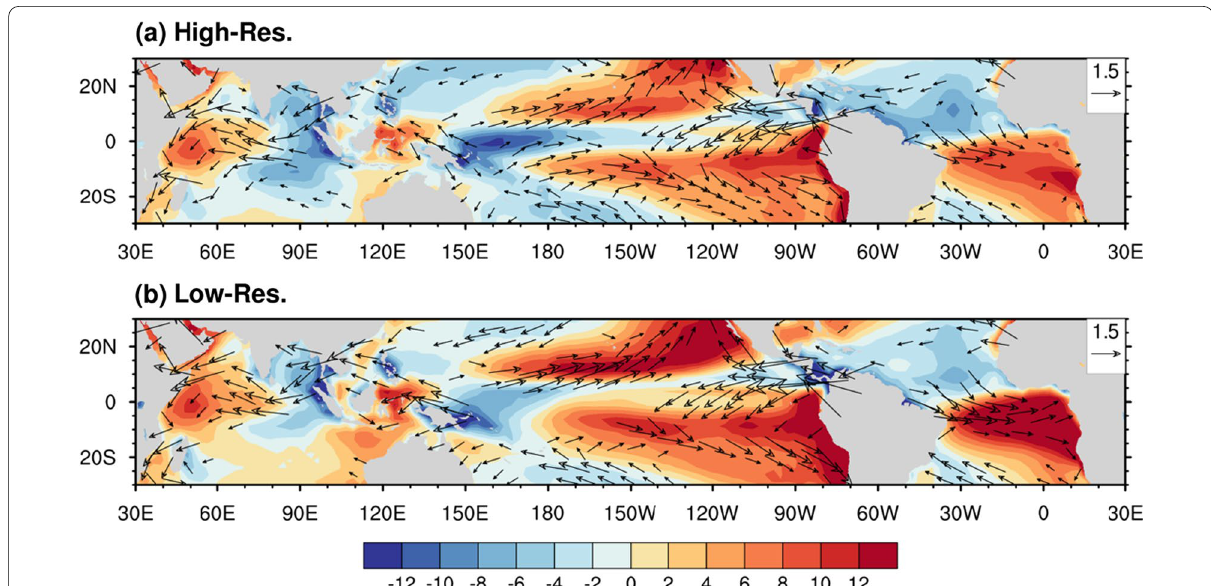
Fig. 11 The spatial pattern of ACRE and 850 hPa‑wind anomalies, calculated as the differences between different groups of model simulations and observations. Models include a high‑resolution and b low‑resolution groups. The observational data for radiation and wind fields are taken from CERES and ERA5, respectively. The color interval is 2 wattm − 2 . The wind vectors exceeding 95% confidence level are plotted, with a scale bar shown at the top‑right corner (in unit of ms − 1